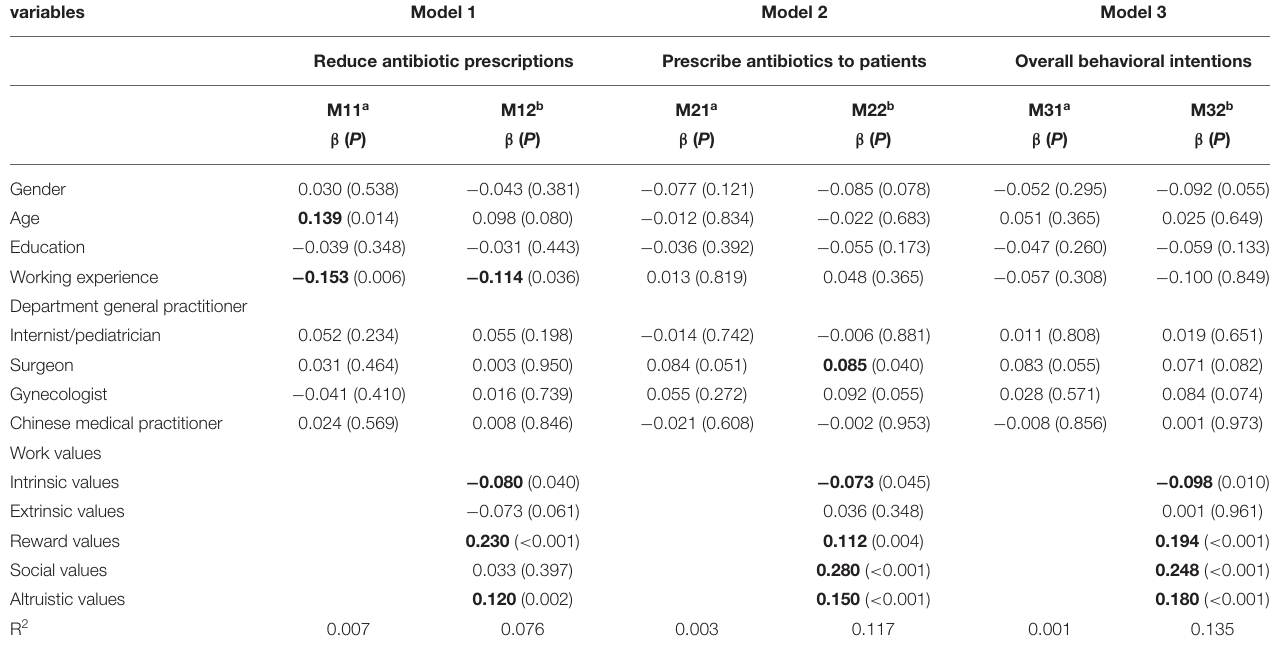
TABLE 3 | Influencing factors of work values toward behavioral